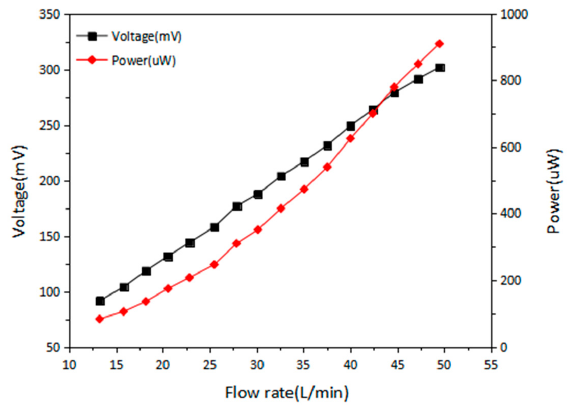
Figure 9. Terminal voltage and power of EMG against water flow rate.